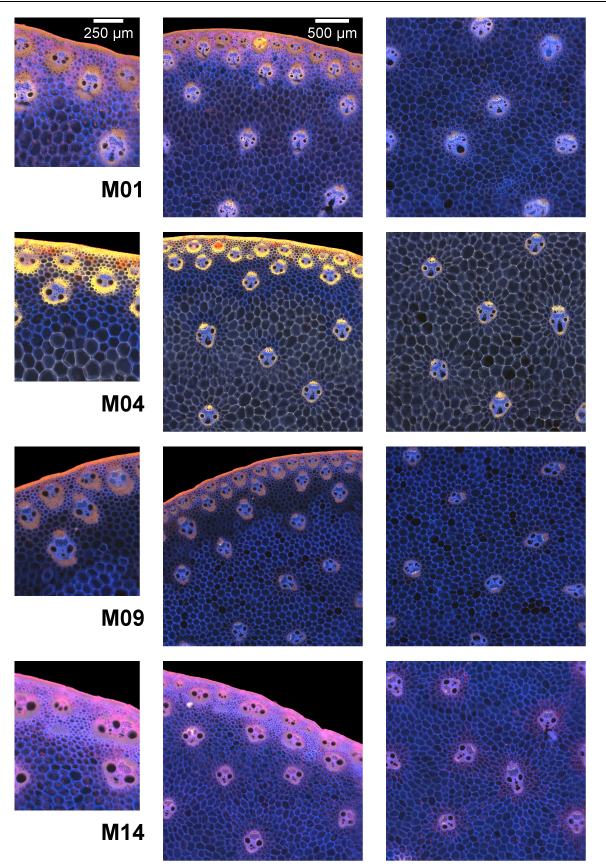
FIGURE 4 | Composite macrofluorescence images. Example of inbred lines. Fields of view: 1.06 × 1.27 mm 2 for the left column images and 3 × 3 mm 2 for the middle and right column images. Blue fluorescence represents cell walls whose fluorescence is mainly induced by UV excitation, while pink or yellow fluorescence represents cell walls whose fluorescence is induced by visible excitation. Differences between the four inbred lines were observed for all